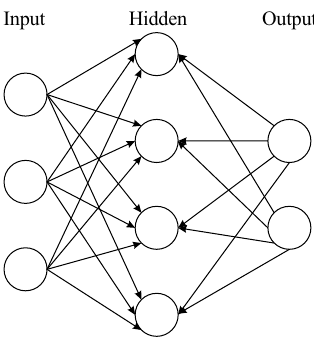
Fig. 1 Architecture of